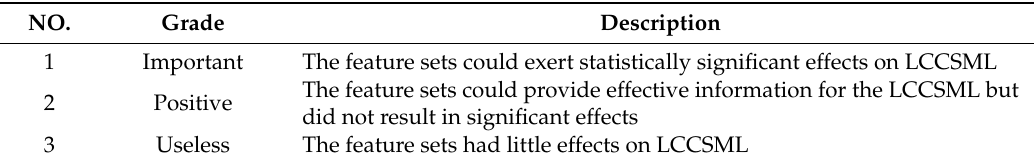
Table 14. Descriptions of the three defined importance grades of feature sets in this study.